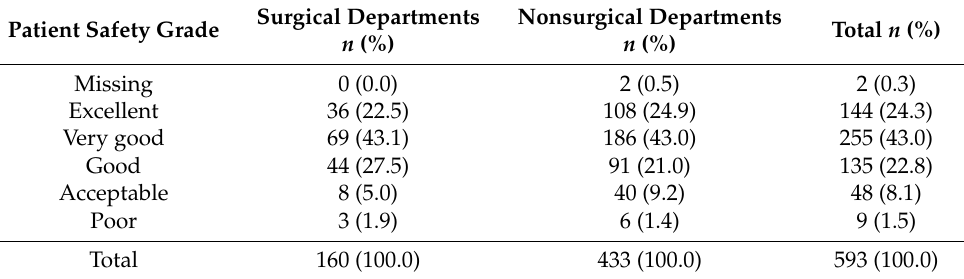
Table 4. Overall assessment of patient safety grade in Surgical and Nonsurgical